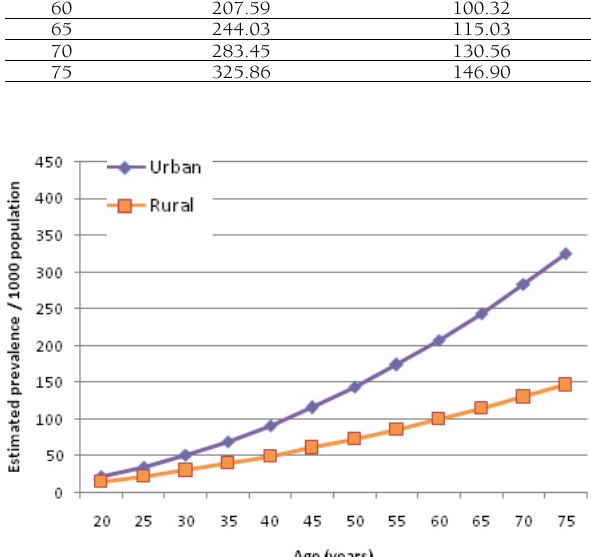
Figure 10. Comparison of the prevalence of type 2 diabetes in Southern Asia by age in urban and rural regions – both sexes included.